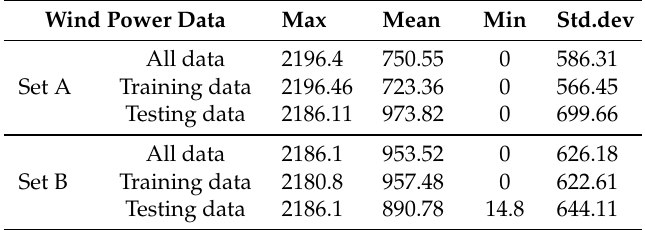
Figure 5. Original wind power time series(kW). ( a ) Wind power dataset A. ( b ) Wind power dataset B. Table 1. Statistical description of the empirical wind power